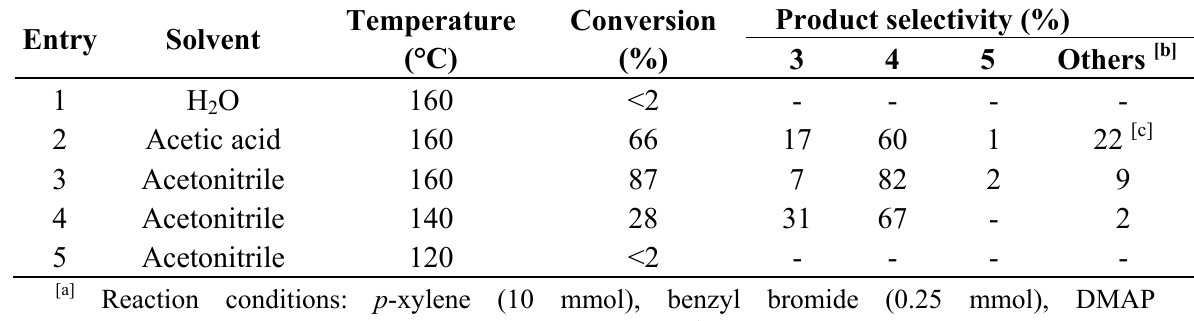
Table 2. Oxidation of p -xylene in different solvents [a] .